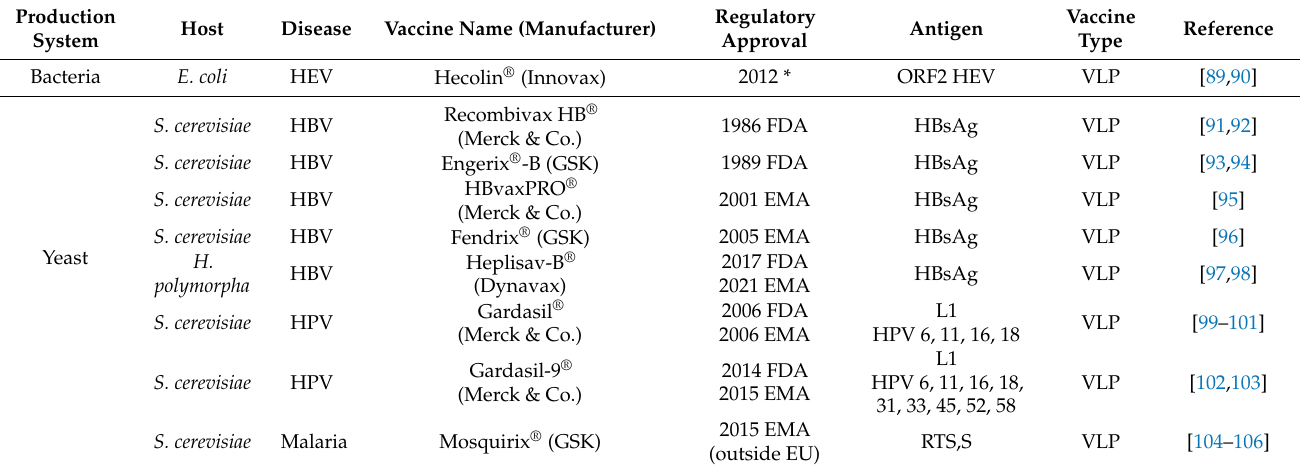
Table 1. Recombinant protein vaccines approved for human